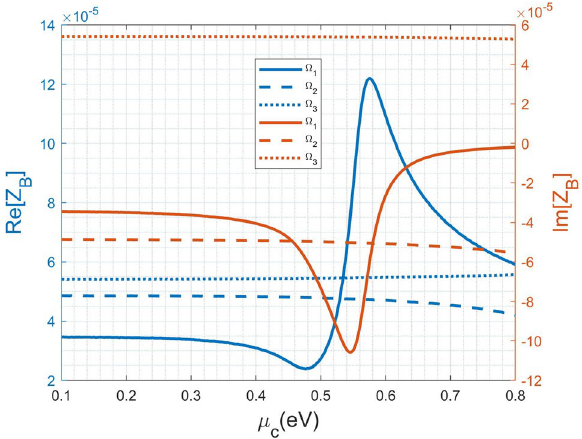
Figure 7. Variation of the Bloch impedance ( Z B ) against chemical potential ( µ c ) for the first three modes with normalized frequencies (cid:31) 1 = 1.3333 , (cid:31) 2 = 2.66666 , and (cid:31) 3 = 3.99999 ,